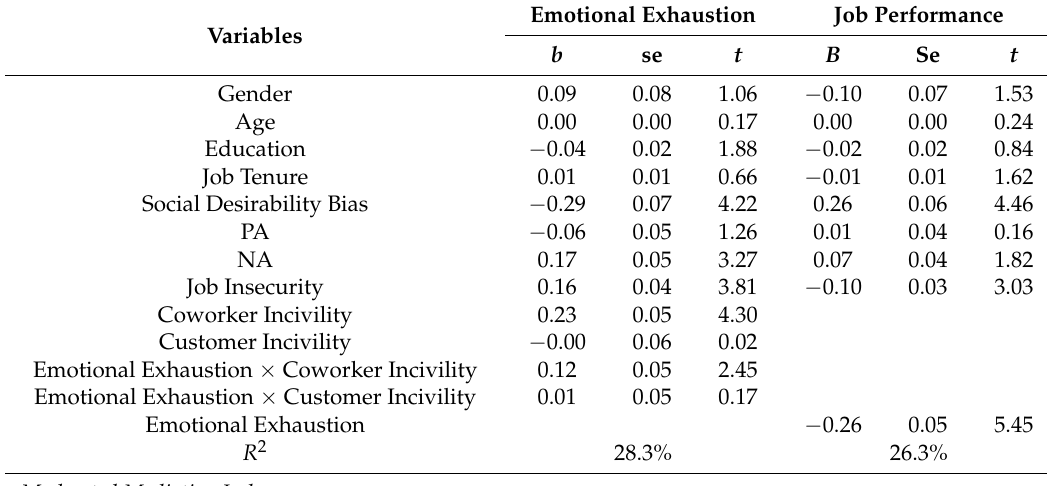
Table 4. Test of the conditional effect of job insecurity on job performance through emotional exhaustion.